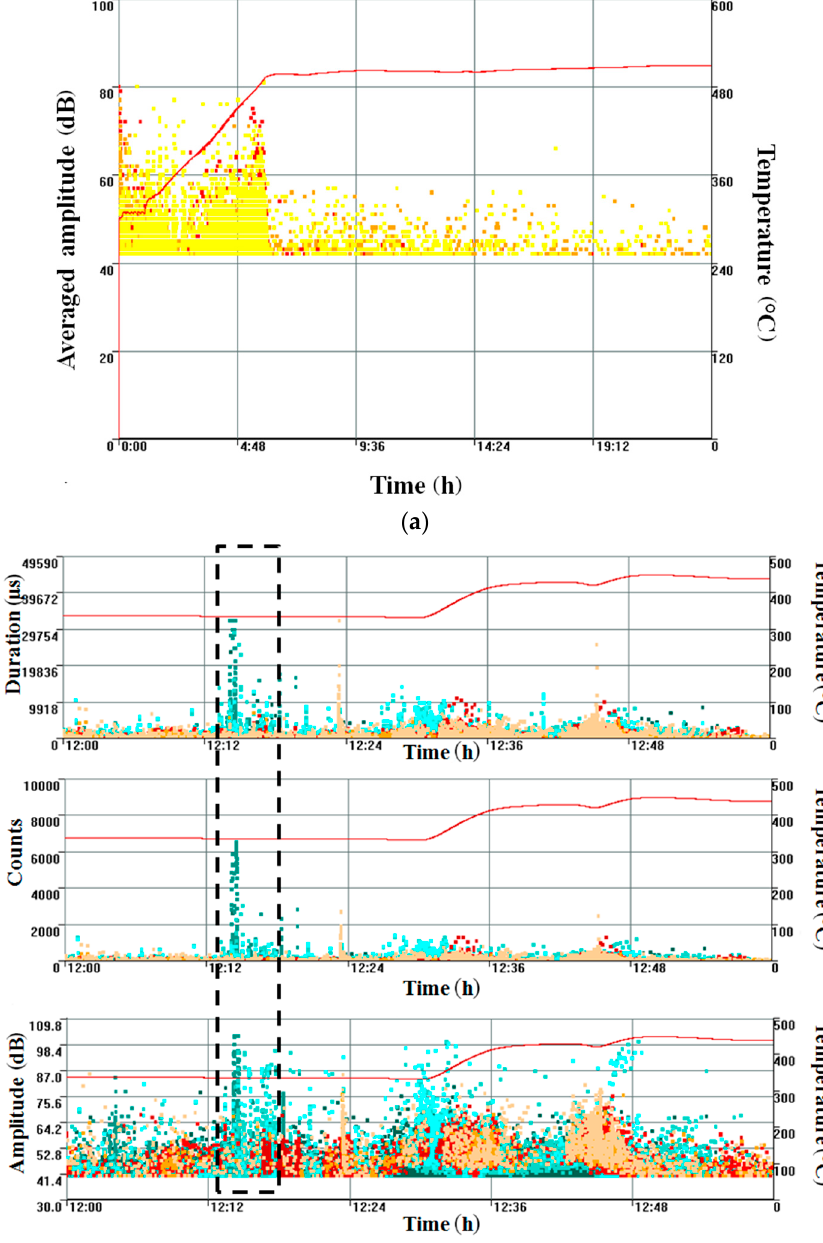
Figure 11. Amplitudes of noise depend on the pipeline temperature ( a ); the melt leakage ( b ). Colors of points indicates different channels.